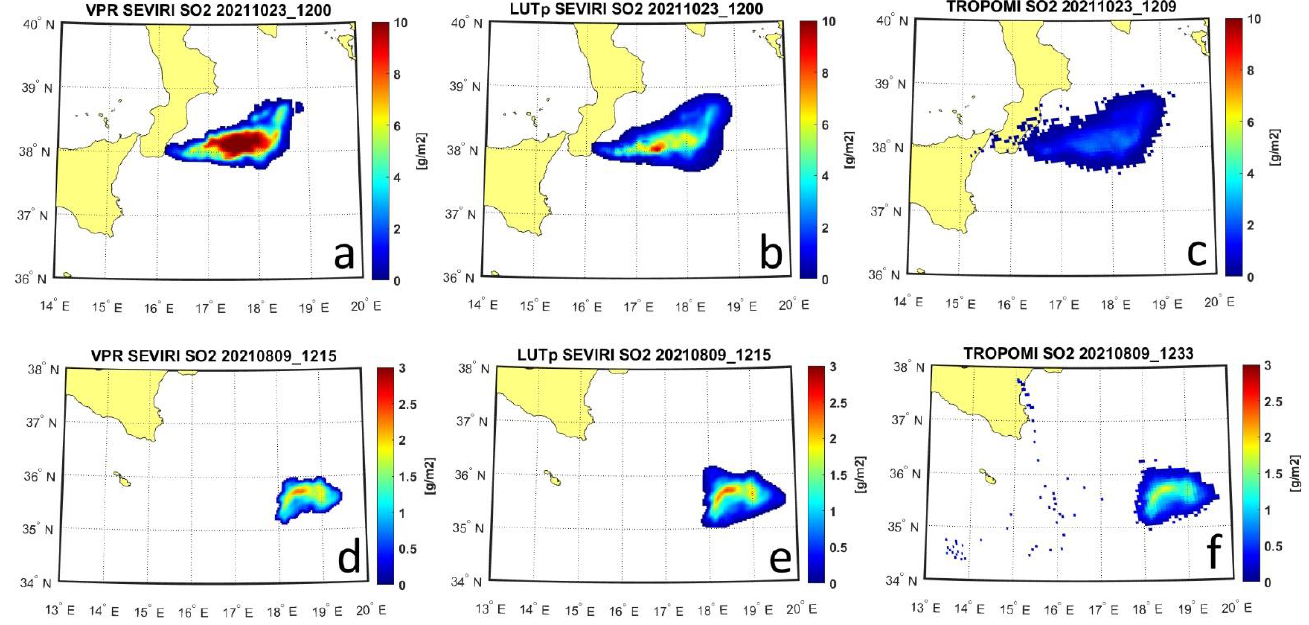
Figure 14. SO 2 column densities [g m − 2 ] from SEVIRI-VPR ( a , d ), SEVIRI-LUT p , ( b , e ), and TROPOMI ( c , f ) for two LF episodes (at the top the 23 October 2021, at the bottom the 9 August 2021). Note that the color ramp for the two LFs is not the same.